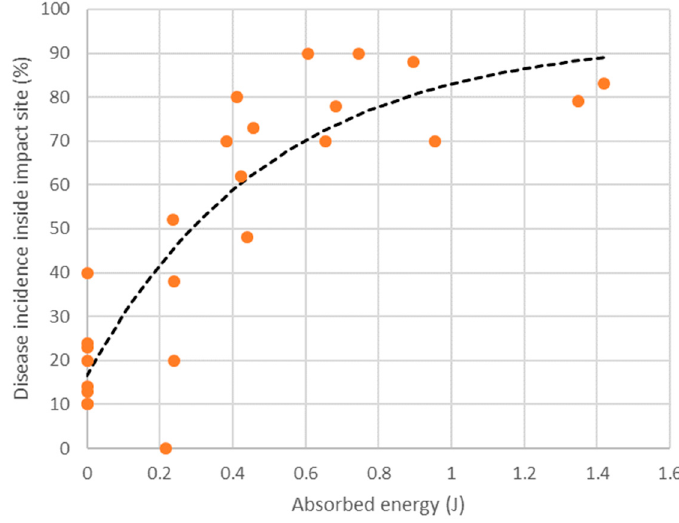
Figure 3. Relationship between disease incidence inside the impact site at soft-ripe stage and energy absorbed by unripe ‘Hass’ avocado fruit upon impact. Data points represent mean values for each drop height treatment and were obtained from eight experiments. Dotted line represents a nonlinear asymptotic regression equation (disease incidence proportion = 0.936176 − 0.771635 × exp( − 1.98249 × absorbed energy); S = 0.15; lack-of-fit p = 0.075; n = 25), in which disease incidence proportion has been converted to a